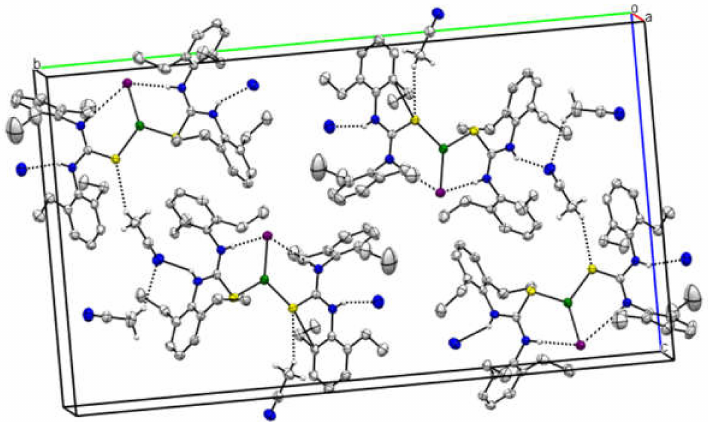
Figure 6. Perspective drawing of the packing arrangement of 1b in the crystal along a, b and c axes. Only N-H and CH 3 hydrogens of acetonitrile are shown. Color scheme: Cu = green; S = yellow; N = blue; Br = purple; C = grey; and H =